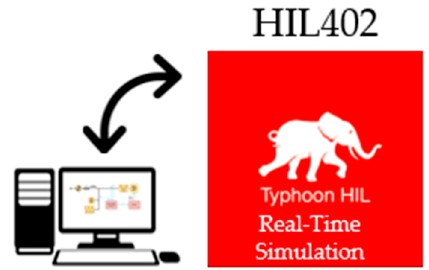
Figure 9. Real-time simulation platform.